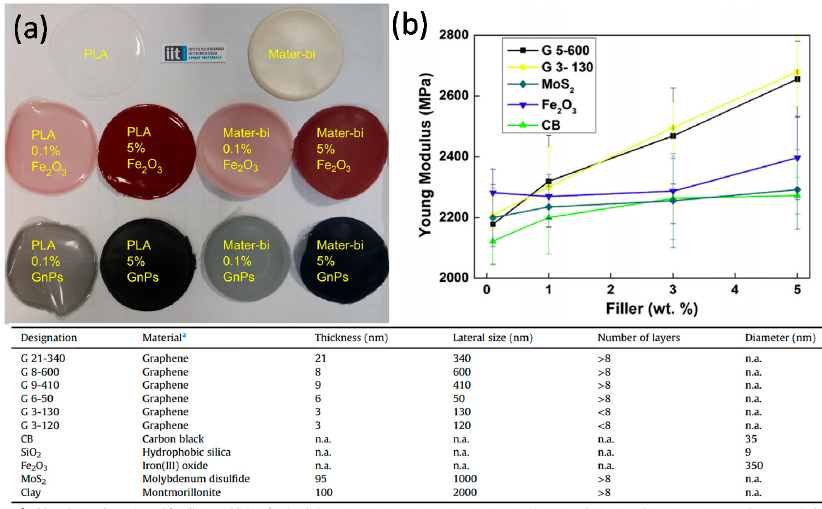
Figure 16. ( a ) Photograph of different solvent-cast composite films from PLA and Mater-Bi ® (Novamont, Italy) biopolymers. Transparent and whitish films featured on the top are two unfilled matrices; ( b ) Elastic modulus versus filler weight percent measurements for solvent-cast PLA polymer matrix composites; ( c ) The table lists dimensional characteristics of all the nanoscale fillers used [74].